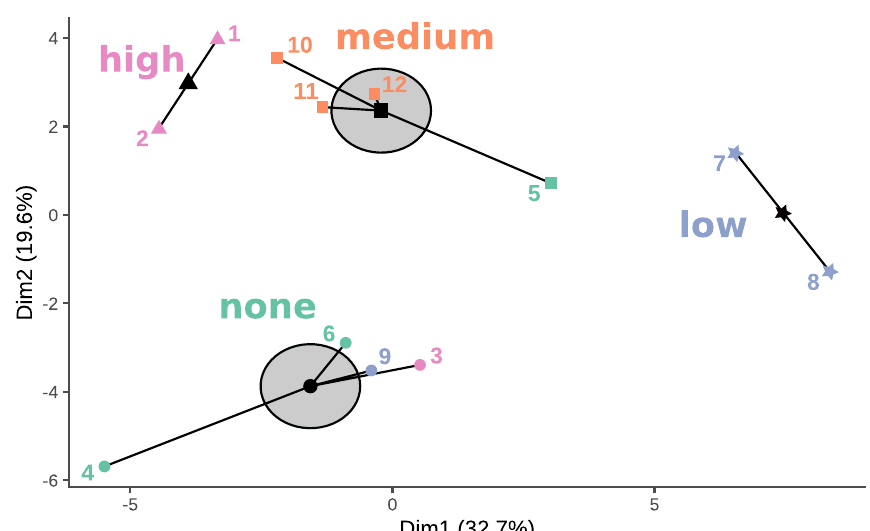
Fig. 4 Clusters of anthropogenic disturbances levels. Results refer to a k-means clustering analysis with observations represented along the first two principal components explaining ca. 33% and 20% of the observed variance in forest structure. Numbers refer to stands with varying levels of anthropogenic disturbance: none (stands 4, 5, and 6), low (stand s7, 8, and 9), medium (stands 10, 11, and 12), and high (stands 1, 2, and 3)